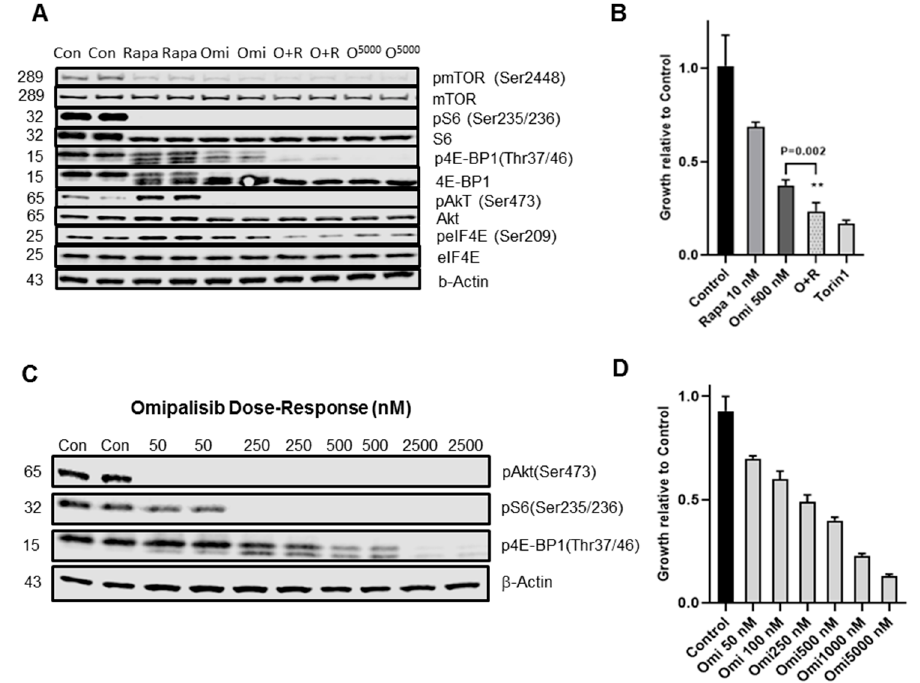
Figure 4. Omipalisib inhibition of pS6, p4E-BP1, and growth in TSC2-null TTJ-L cells. ( A ) TTJ-L cells were grown in the presence or absence of compounds for 16–18 h in a serum-deprived medium and the proteins were identified by immunoblot, as described in Materials and Methods. Rapa—